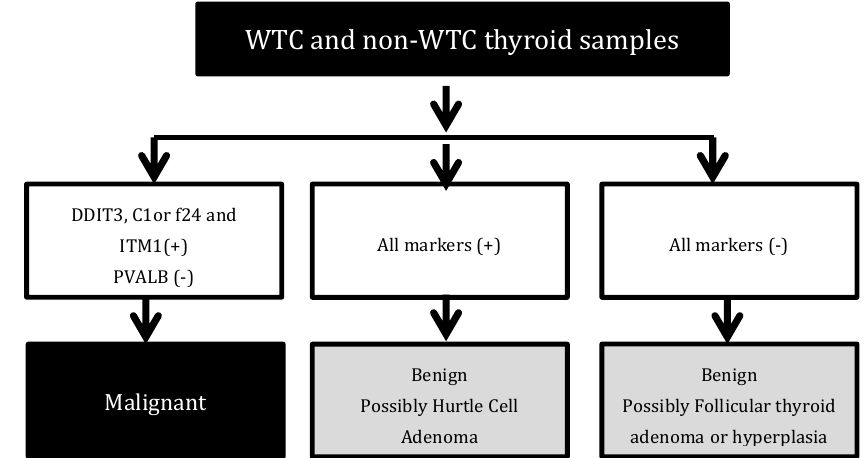
Figure 1. Antibody Assessment. WTC: World trade center